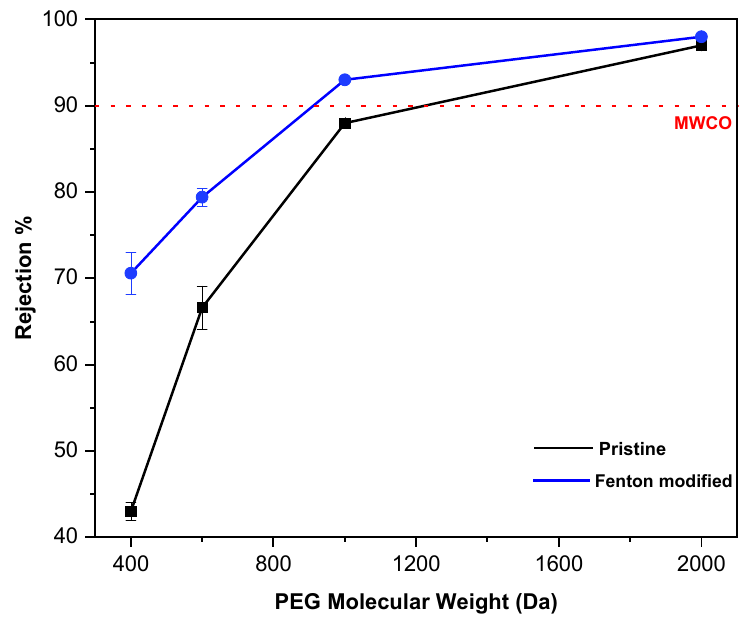
Figure 5. PEGs rejection curves of pristine and Fenton-modified PI membranes for MWCO meas ‐ urement.